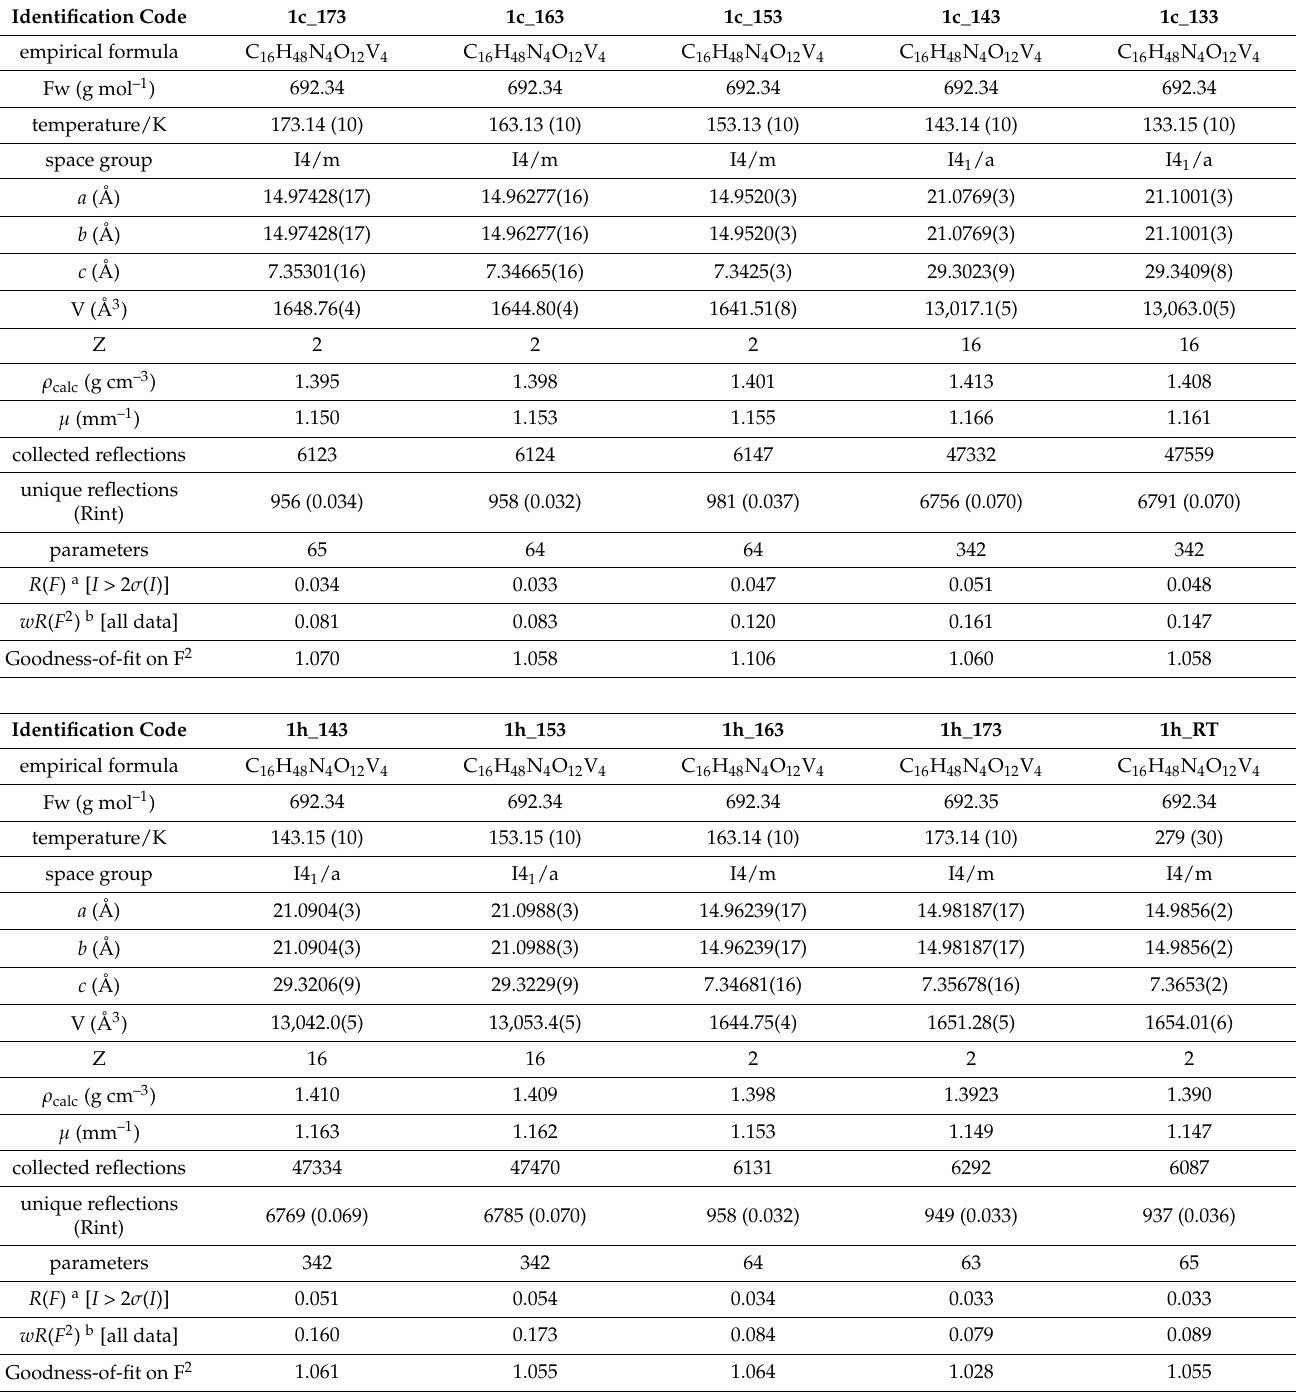
Table 1. Crystallographic data for [(CH 3 ) 3 CNH 3 ] 4 [V 4 O 12 ] at different